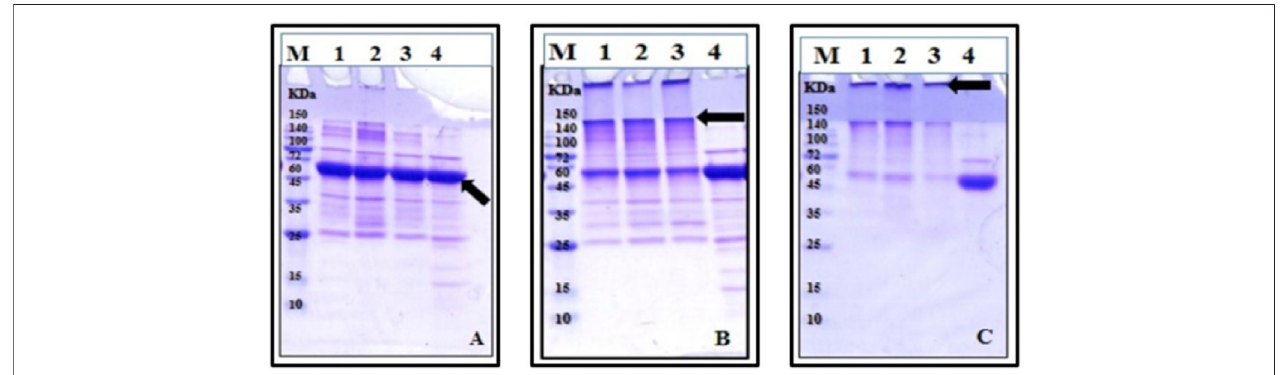
FIGURE 3 | SDS-PAGE analysis of tau protein fi bril formation. Tau protein was incubated for different periods of time: (A) 6 h, (B) 48 h, and (C) 96 h, with 5 mM heparininthepresenceofDTTandthenanalyzedby12%SDSpolyacrylamidegels,followedbyproteinstainingwithCoomassieBrilliantBlue.Thesampledescriptionin gels (A – C) isthesameexceptfordifferentincubationperiods.M,proteinmarker;lanes1 – 3,threereplicatesofthenot-treatedsampleinthepresenceofDTT;lane4,not- heated control tau protein in the presence of DTT.